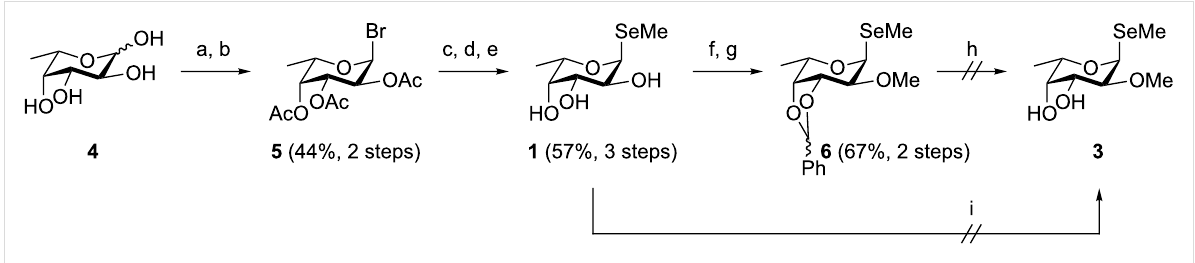
Scheme 1: Synthesis of 3 through initial introduction of the seleno aglycon and subsequent O -methylation. Reagents and conditions: (a) NaOAc, Ac